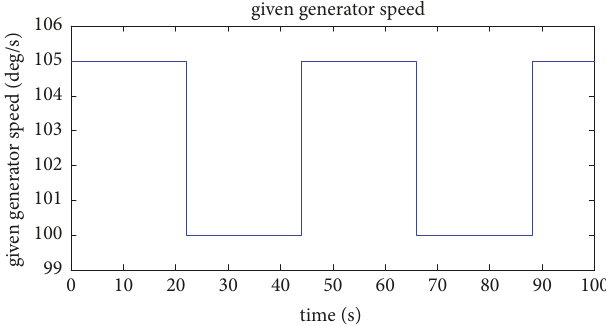
Figure 4: Given generator speed signal.